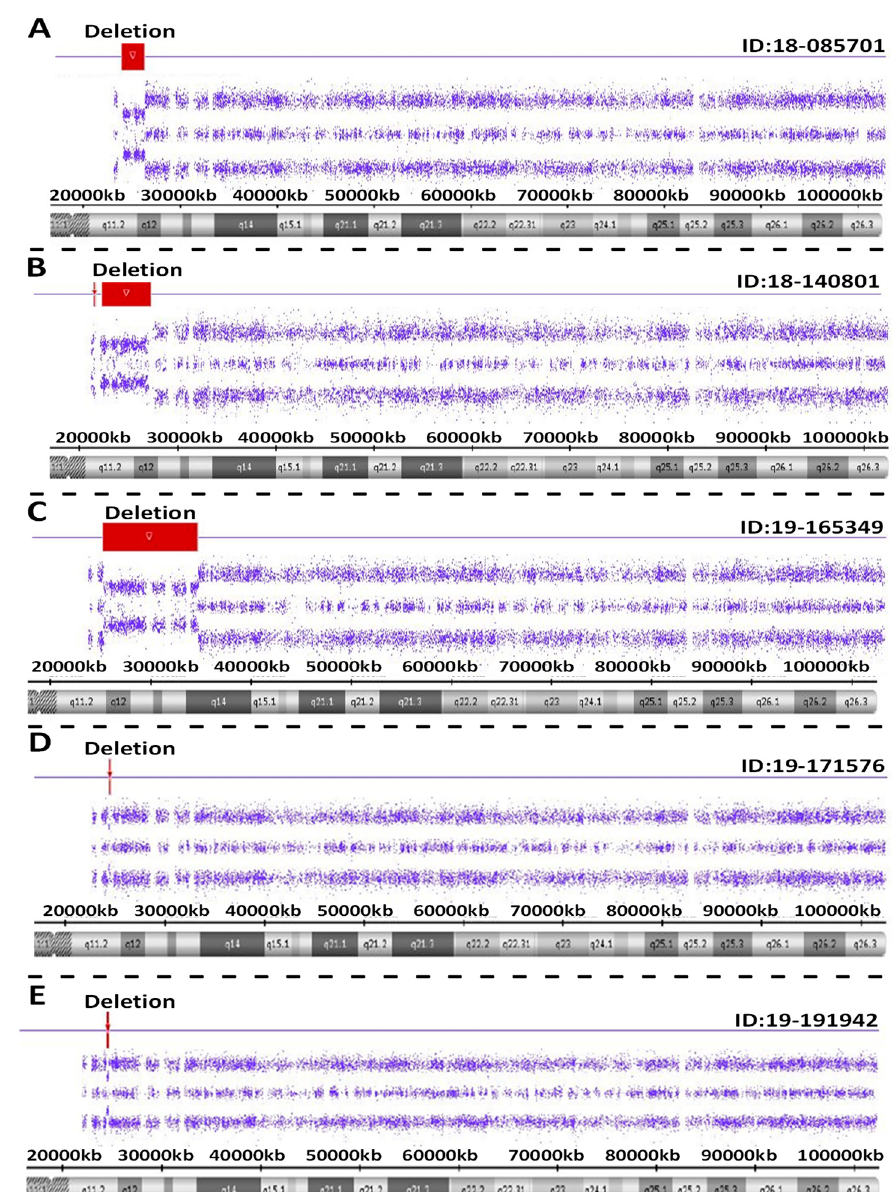
Figure 4. Atypical PWS deletion microarray results with red colored-bars representing the size and location of the deletion on chromosome 15 are shown in five separate PWS participants (A-E). For PWS subject ID #19-165349, a pathogenic copy number change was detected on chromosome 15. This atypical deletion in chromosome 15 included the 15q11-q14 region